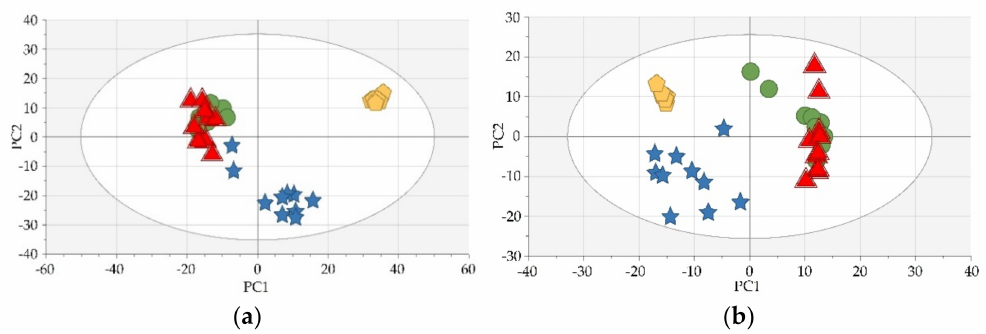
Figure 2. Exemplary score plots of the Principal Component Analysis models (built with the use of SIMCA-P+ 13.0.3 (Umetrics, Umeå, Sweden)) presenting the clustering of QCs. The clustering assessment was made in order to verify systems stability for analysis using ( a ) LC-HILIC-MS in positive ionization mode and ( b ) LC-RP-MS in positive ionization mode. Legend: green circles—“1” (first time point, samples collected before TURBT), blue stars—“2” (second time point, samples collected the day after TURBT), red triangles—“3” (third time point, samples collected 14 days after TURBT), yellow pentagons—QCs. The number of samples: “1” = 10, “2” = 10, “3” = 10, QCs =